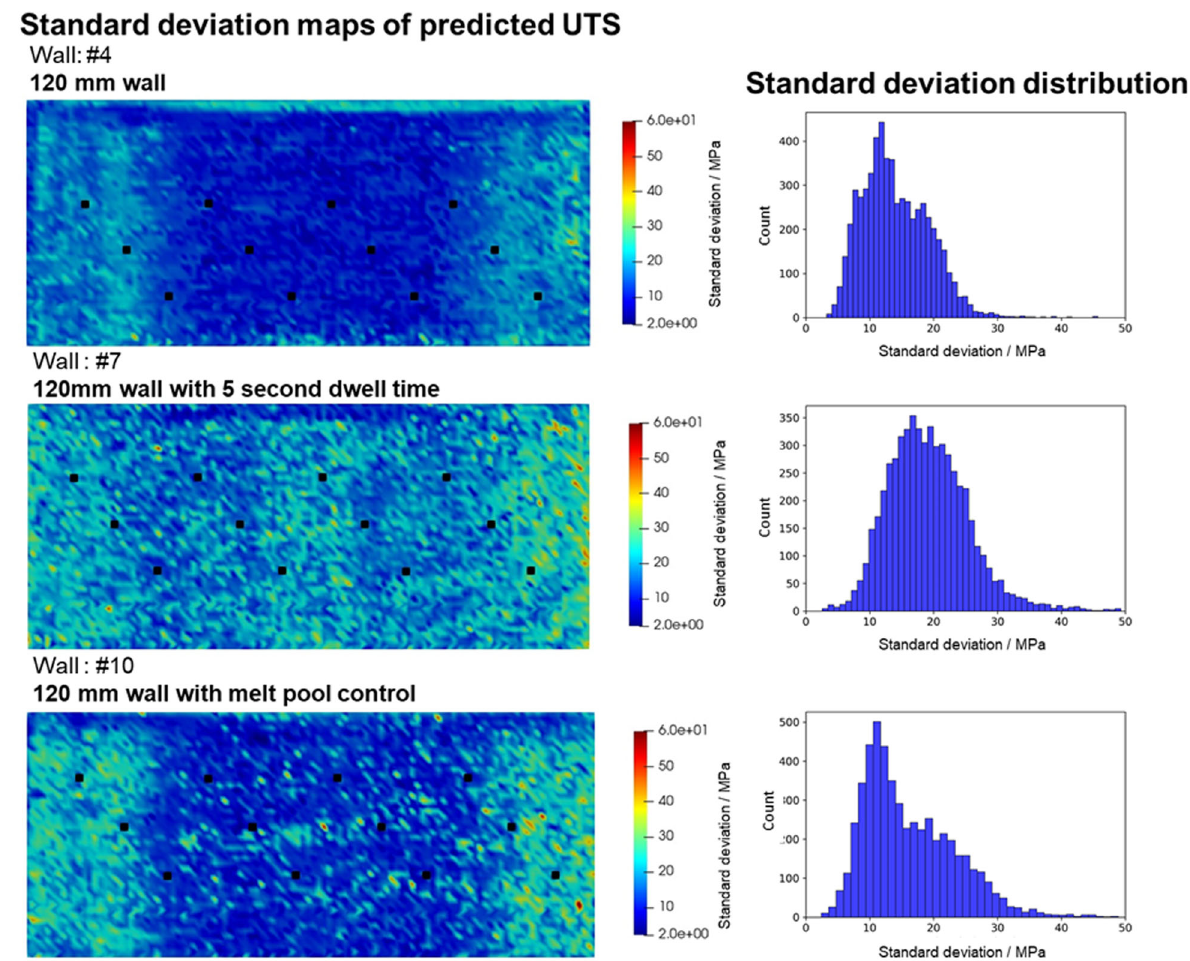
Fig. 3 Standard deviation of predicted UTS for three process conditions. The predicted UTS results are obtained by averaging fi ve CNN outputs. The process conditions include 120 mm wall without any dwell time and melt pool control, 120 mm wall with 5 s dwell time, and 120 mm wall with melt pool control. The positions of tensile specimens are marked as black dots on the left side of sub- fi gures. Three sub- fi gures on the right side show the standard deviation distribution for three process conditions. The distribution analyzes 5000 predicted UTS values at different locations of the thin